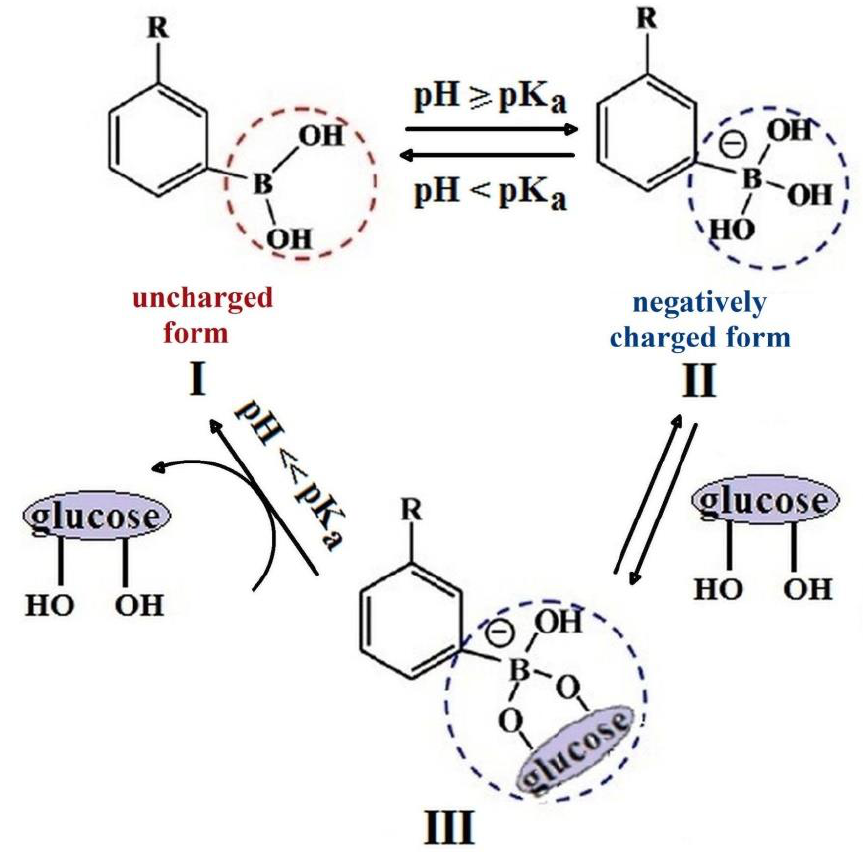
Figure 3. Configurations of PBA in water and complexation equilibrium between PBA-derivatives and glucose.